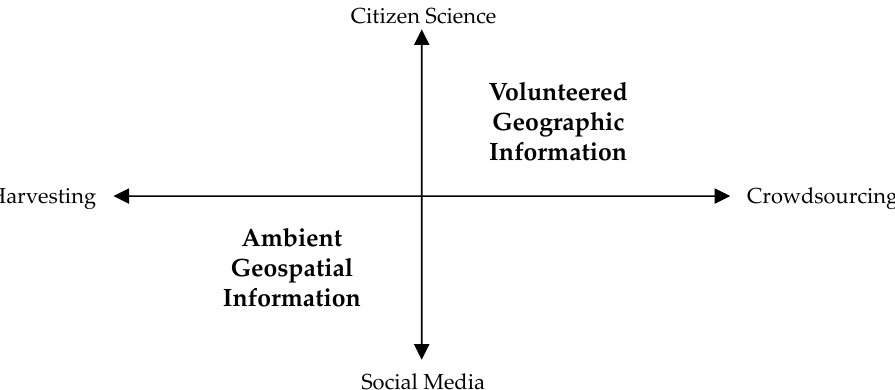
Figure 1. Contextualization of Volunteered Geographic Information (VGI) and Ambient Geospatial Information (AGI) regarding data production (vertical axis) and data collection (horizontal